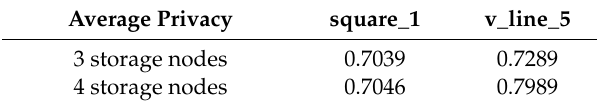
Table 6. Average privacy achieved by the DCA for the topology of 123 nodes.